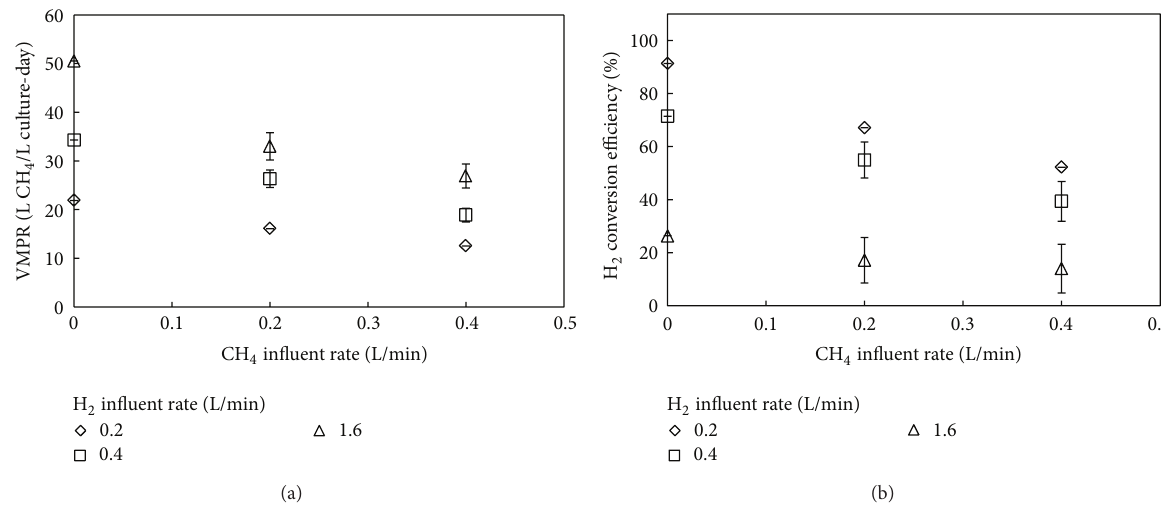
Figure 4: Bioreactor performance for Experiment 3. Volumetric methane production rates (a) and hydrogen conversion efficiencies (b) for bioreactor runs in which the methane influent rate was varied between 0 and 0.4L/min. Data were gathered for three different hydrogen influent rates. The error bars represent the observed variance between runs for each bioreactor condition.